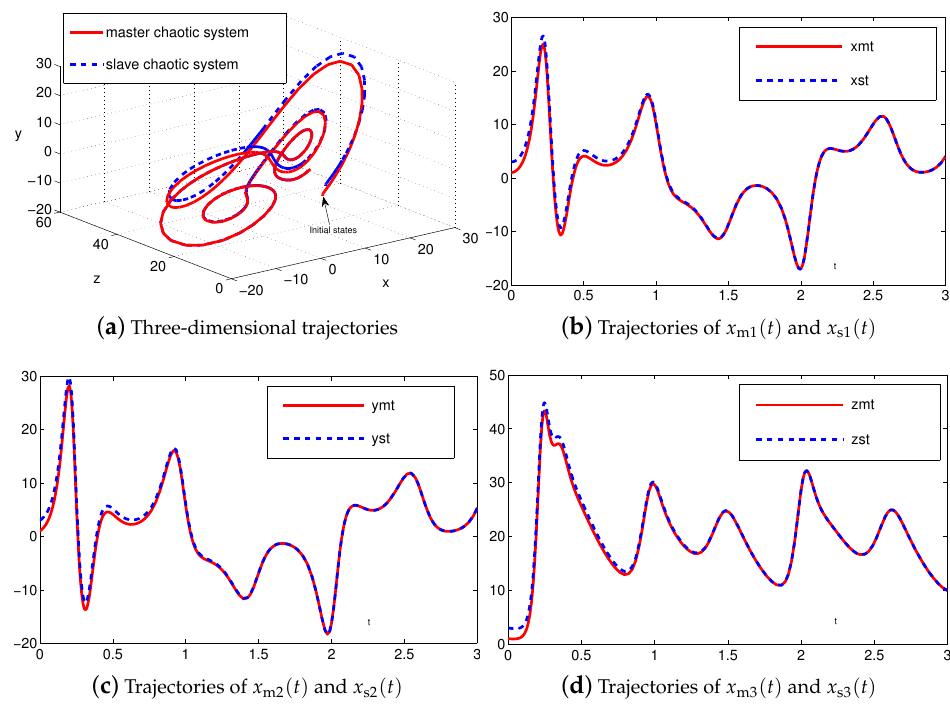
Figure 3. Synchronization performance between two identical Lu chaotic systems (24) and (25) equipped with controller (6) via the proposed super-exponential-zeroing neurodynamic (SEZN)